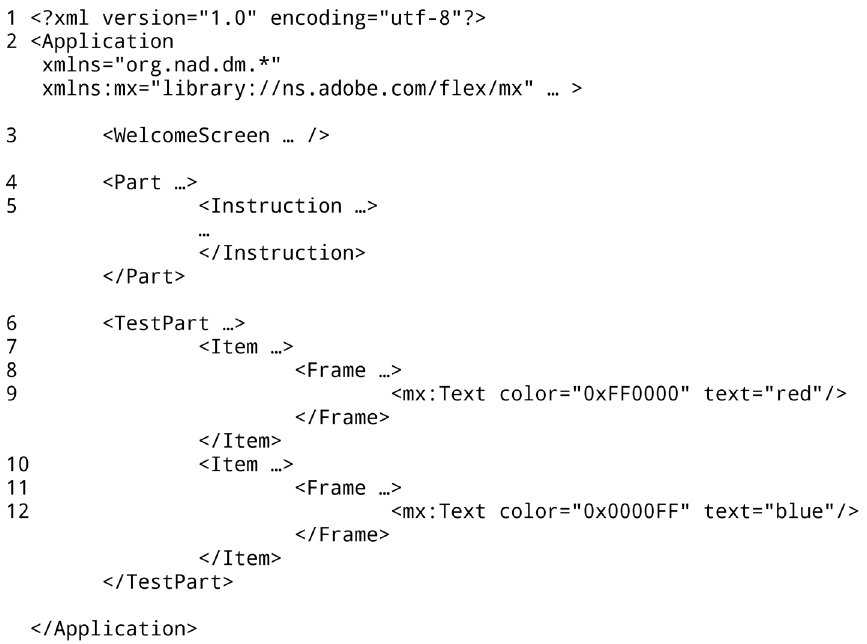
Figure 1. Outline of a Stroop study implemented in ScriptingRT. Excerpt from a ScriptingRT source code file implementing a Stroop paradigm. The tags shown set preferences (tags 1 and 2), create an introductory screen and an instruction screen (3–5) as well as one experimental block with two items (6–12). Tags 1 and 2 are general Apache Flex components. Tags 9 and 12 also embed a general Flex object, a , Text/ . object (referenced in the Application tag with the prefix mx). All other tags are part of the ScriptingRT library (referenced in the Application tag).